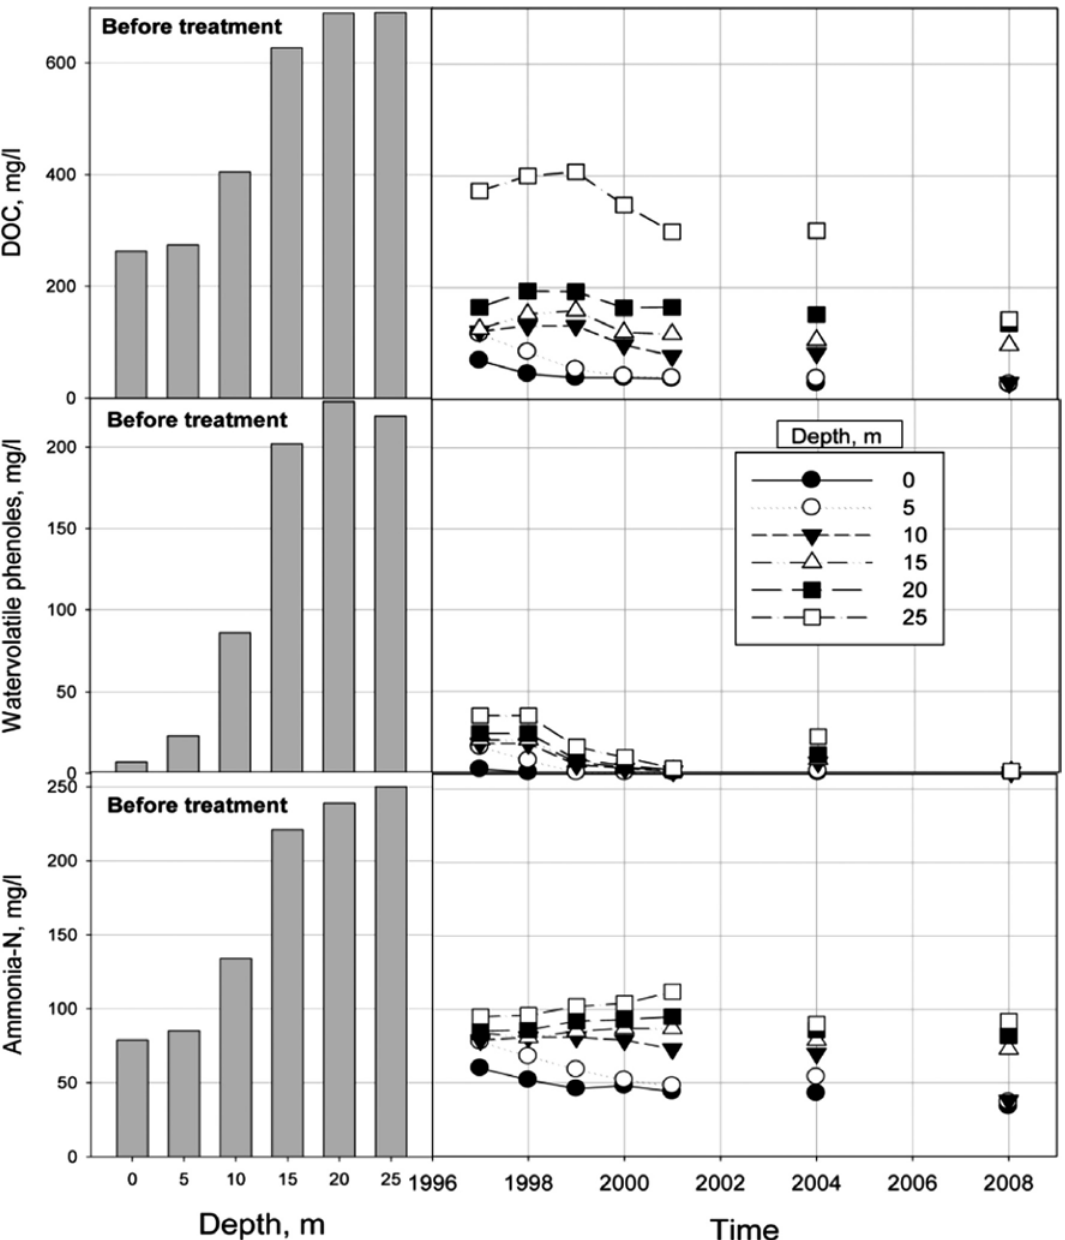
Fig. 7. DOC, watersteam-volatile phenols and ammonia-N before remediation and long-term monitoring of the parameters during and after the in-situ remediation of the disposal